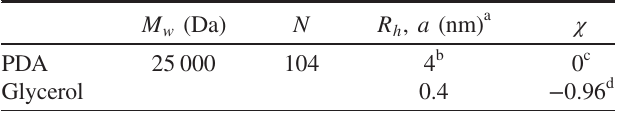
TABLE II. Sample parameters for the spinning drop tensiom- etry experiments of Refs.